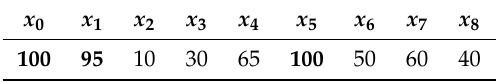
Table 6. Percentage occurrence of each feature in the models evolved by CGP in all the runs. The most occurring features are reported in bold, while the less occurring features are reported in italics.